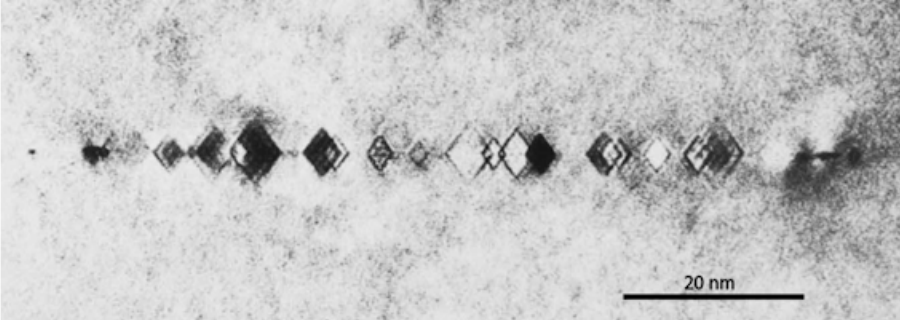
Figure 9. Voidite sheet in type Ia diamond. Reproduced with permission from [64]. Royal Society, 1987.